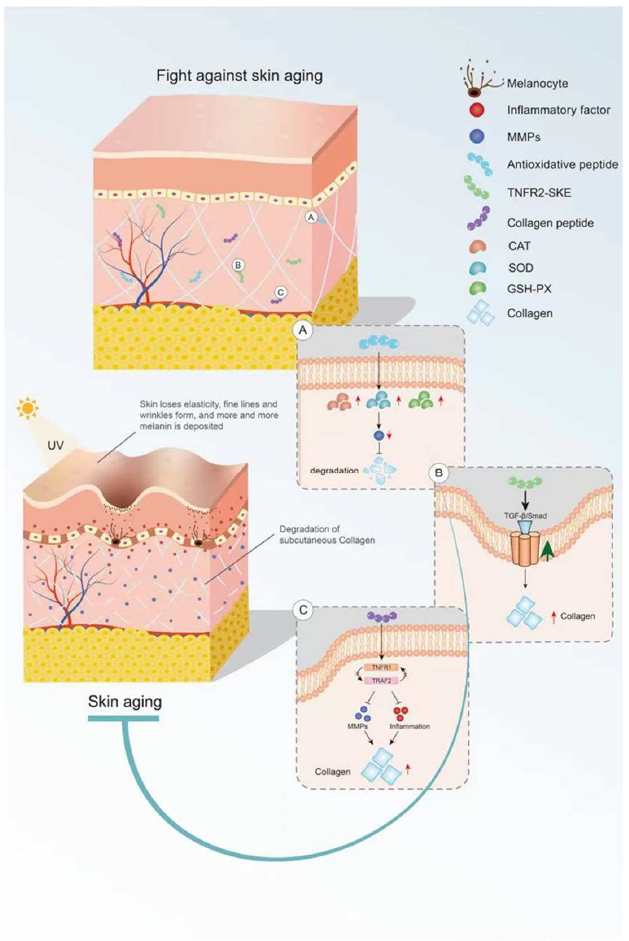
Figure 1. Mechanism of bioactive peptides in delaying skin aging. ( A ) Antioxidant peptides can increase the activity of antioxidant enzymes. ( B ) Bioactive peptides retard skin aging through the TGF-β/Smad pathway. ( C ) Active peptides inhibit inflammation and MMP activity. This figure cannot be reproduced without author permission.